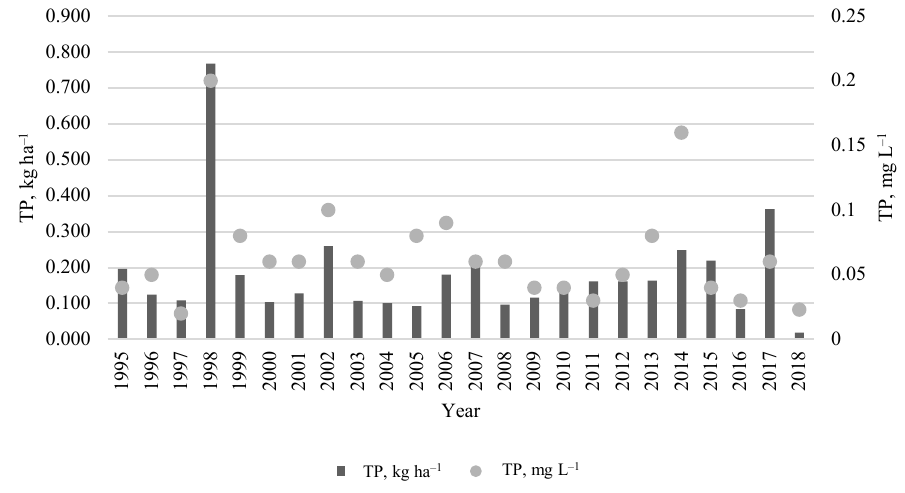
Fig. 4. Annual losses (kg ha –1 ) and concentrations (mg L –1 ) of total phosphorus (TP) in the Mellupite subsurface drainage field.